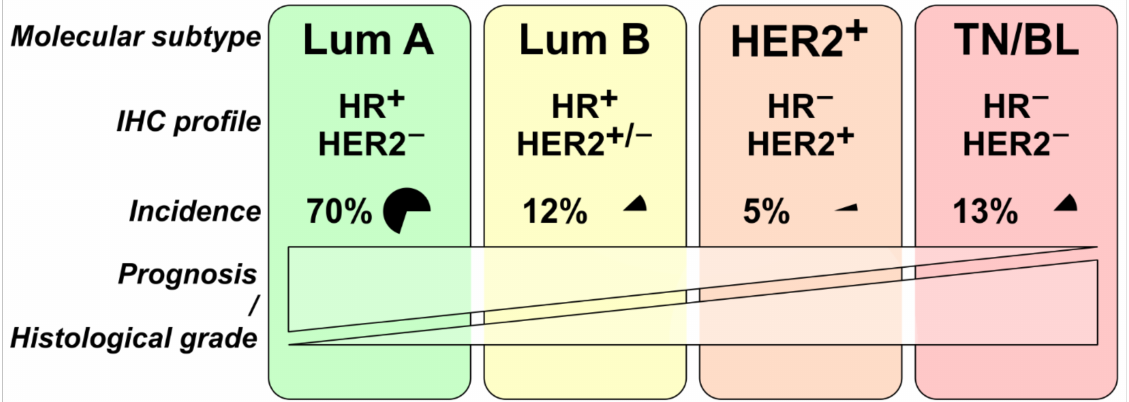
Figure 2. Schematic representation of selected breast tumor statistics, based on [55]. Lum = luminal, TN/BL = triple-negative/basal-like, HR = hormone receptor. Statistics adapted from [39,41], based on identifiable